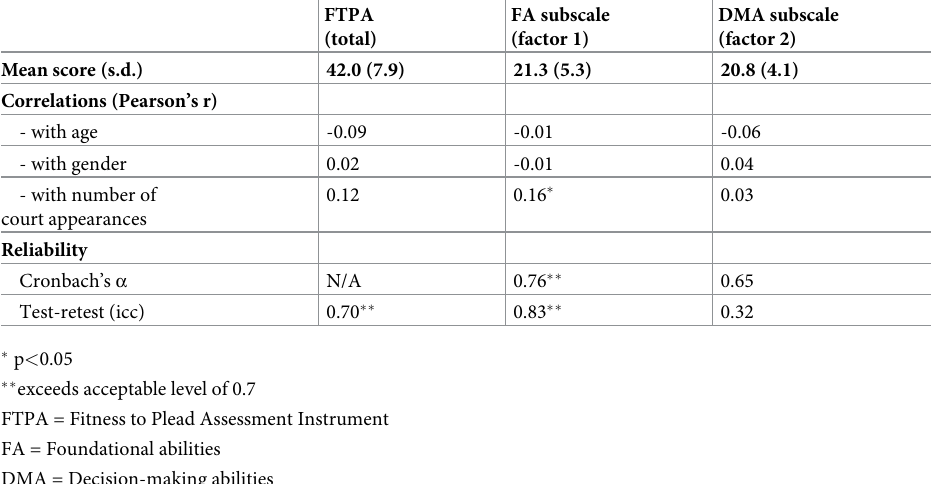
Table 3. Score distributions and reliability of the FTPA-instrument and sub-scales.